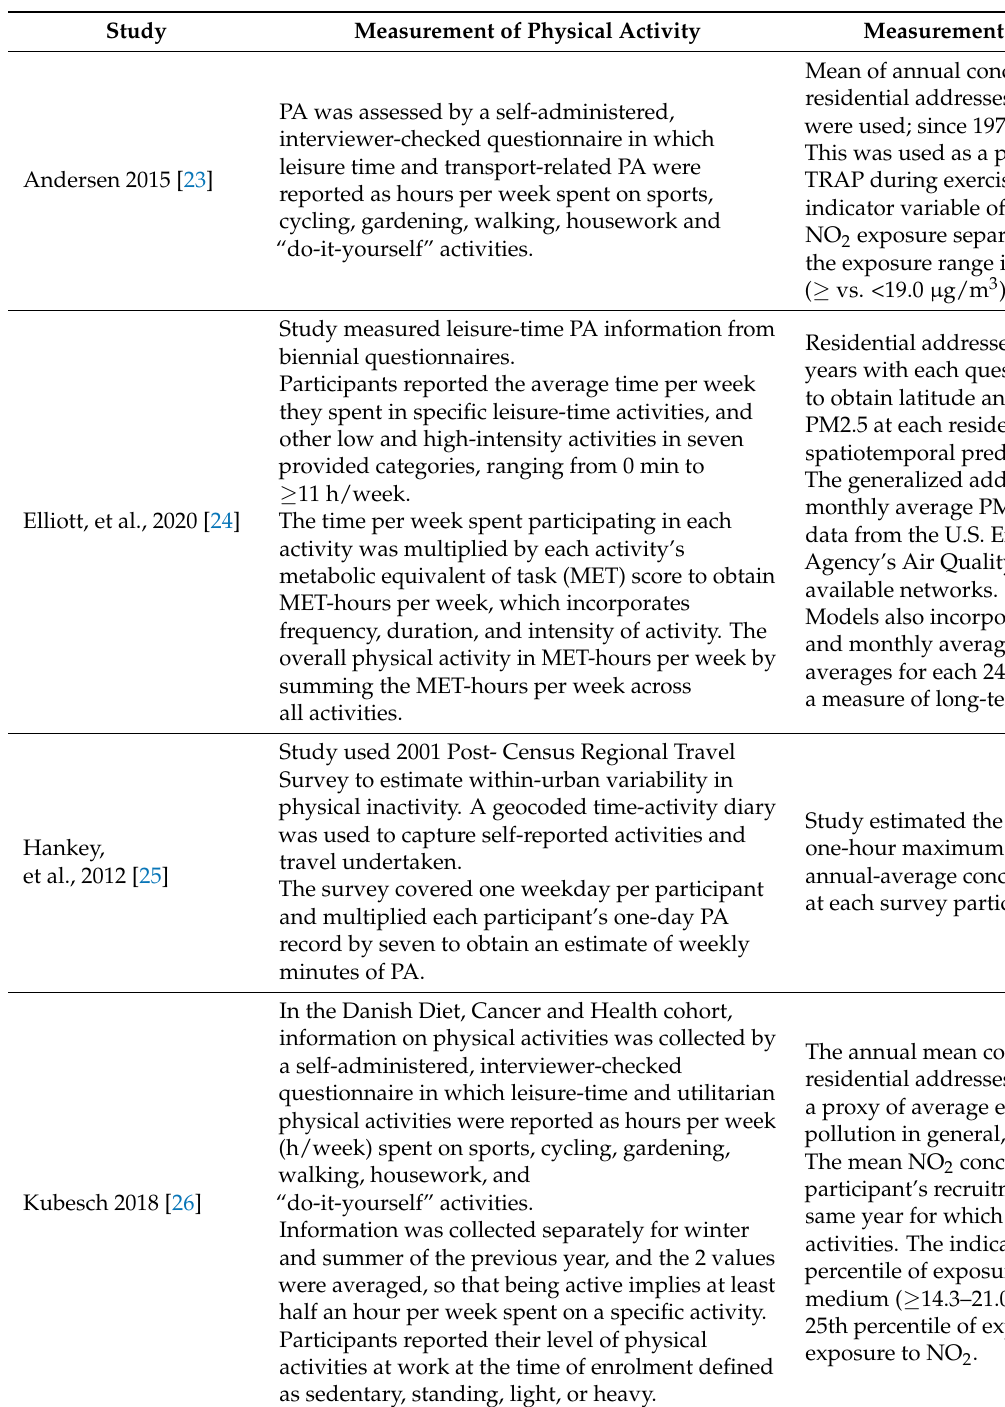
Table 2. Measurement of independent